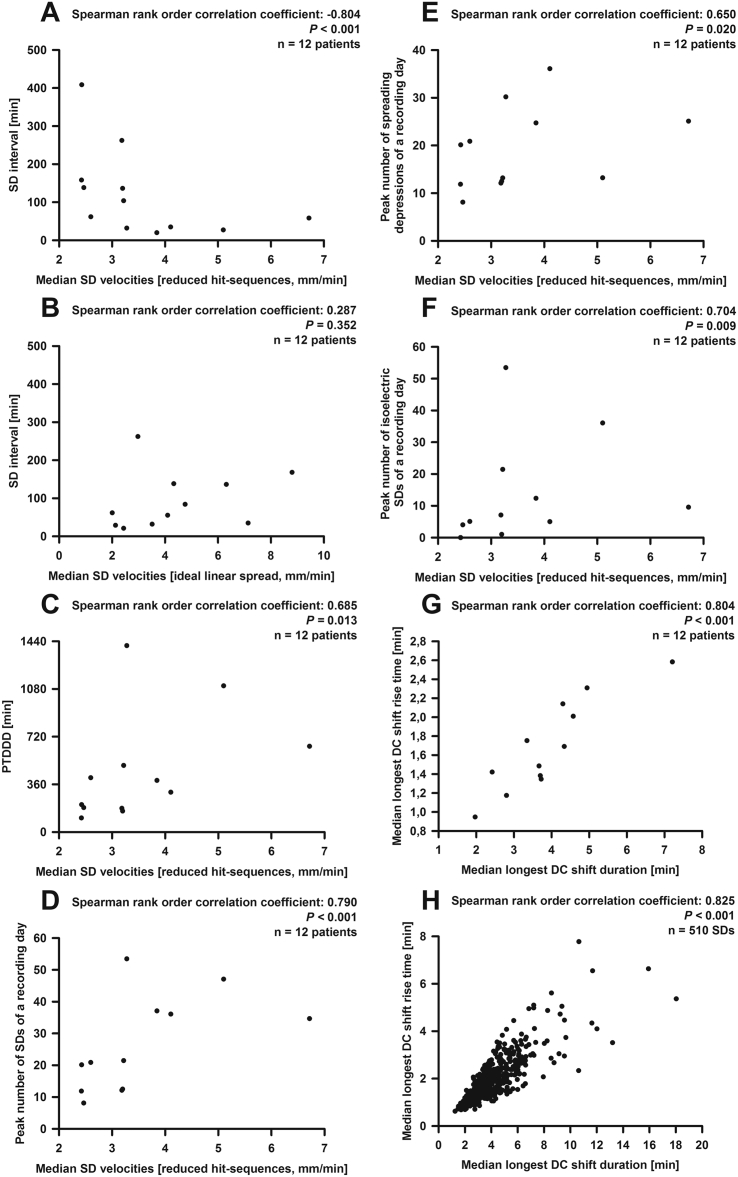
Statistical analyses of the simulation-estimated velocity based on the reduced hit-sequences. (A) A significant correlation of median velocity (based on the reduced hit-sequences) and median interval between SD and previous SD was found. (B) By contrast, there was no correlation of median interval between SD and previous SD with the median velocity based on an ideal linear spread along the recording strip (using the inter-electrode space of 10 mm). This is noteworthy because this type of velocity has been used in all previous COSBID publications that reported SD velocities to indicate the spread of the wave. Significant correlations of the median velocity (based on the reduced hit-sequences) were also found with (C) the PTDDD, (D) the peak number of SDs, (E) the peak number of spreading depressions and (F) the peak number of isoelectric SDs. (G) DC duration and DC rise time showed a strongly positive correlation when the medians were taken. (H) However, the correlation was even stronger using the pooled data which corresponds to the notion that the nature of this relationship is less complex than the relationship between SD velocity and susceptibility.